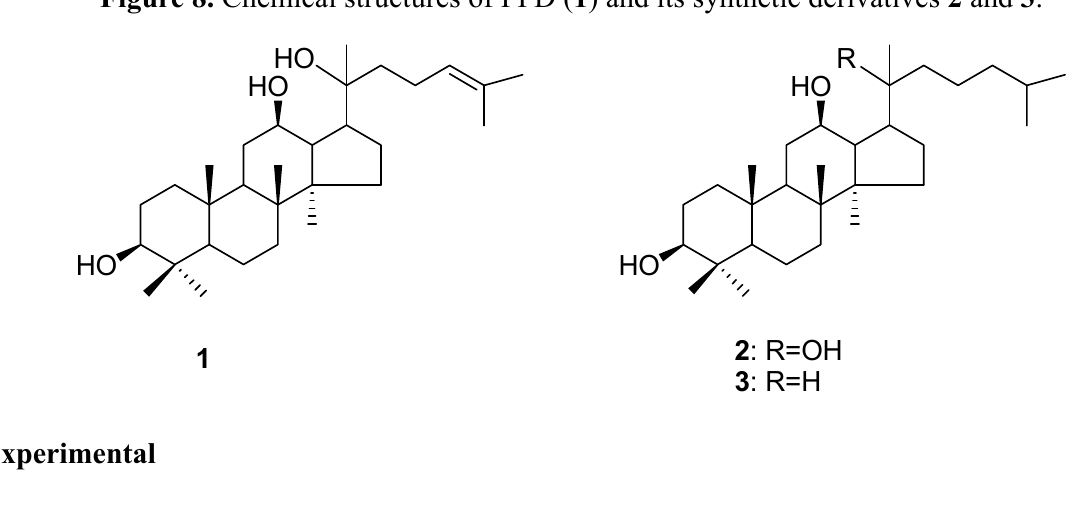
Figure 8. Chemical structures of PPD ( 1 ) and its synthetic derivatives 2 and 3